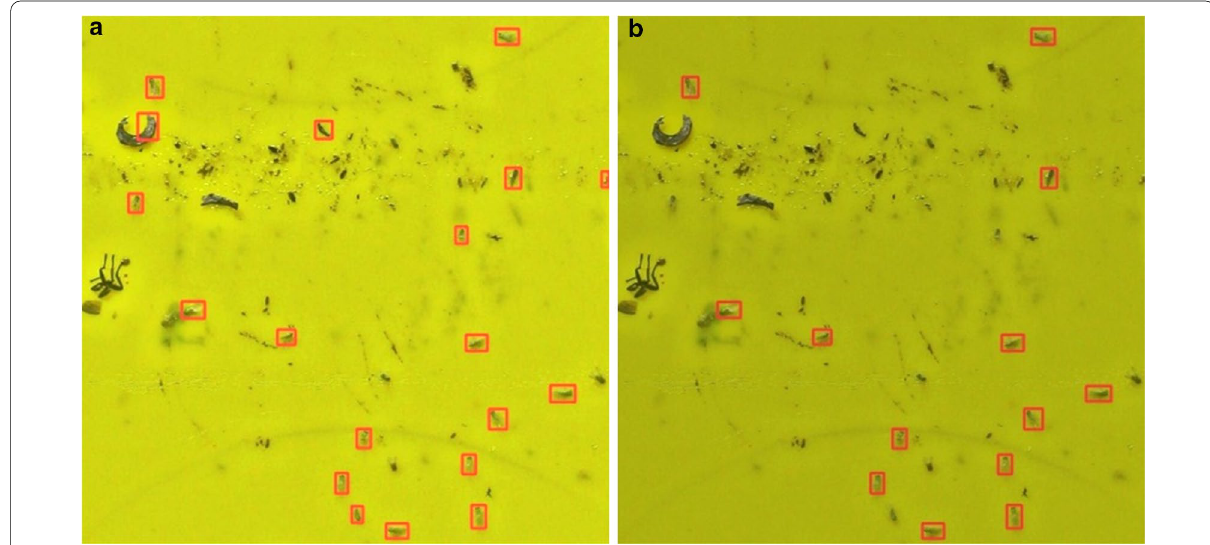
Fig. 2 a An image with many debris where YOLO v5 counts several false positives with the default confidence threshold (0.25); b a confidence threshold of 0.70 eliminates most false